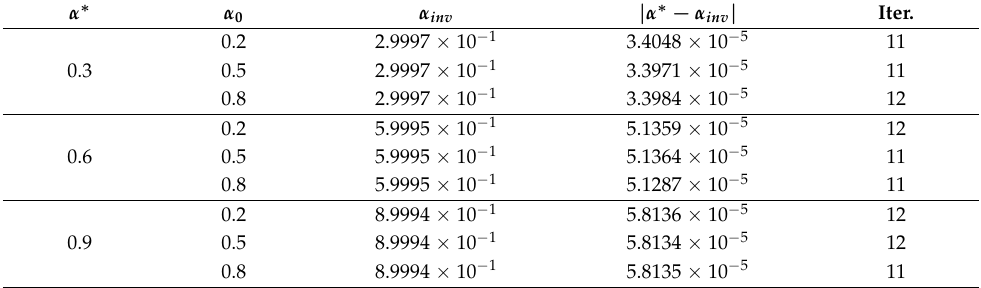
Table 3. Numerical observation of different α ∗ = 0.3,0.6,0.9 with different initial guesses α 0 = 0.2,0.5,0.8 in Test 1.